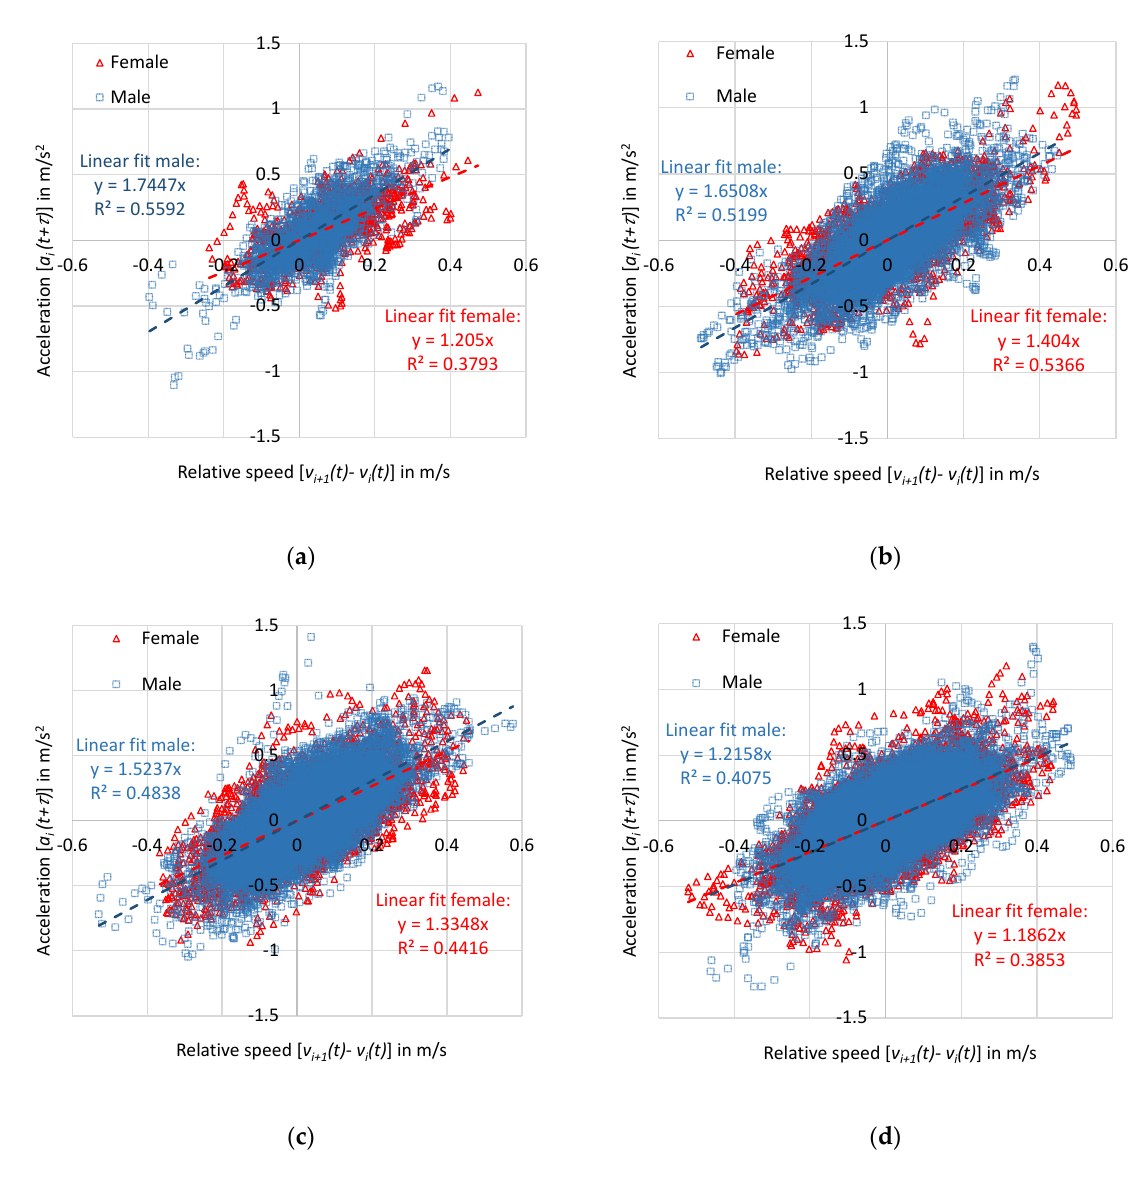
Figure 4. Relative speed versus time-delayed instantaneous acceleration plots for different density levels: ( a ) N = 14; ( b ) N = 20; ( c ) N = 24; ( d ) N = 30. Relationships between acceleration and walking speed for different density levels